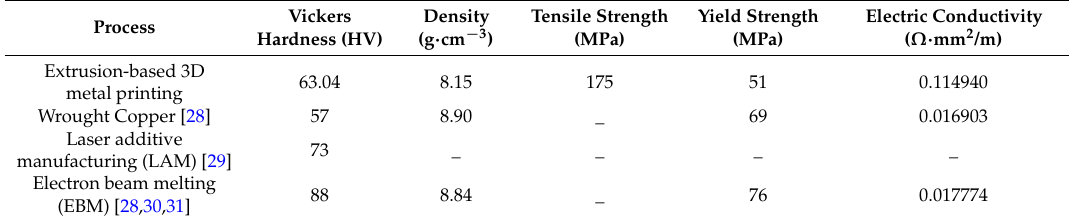
Table 9. Properties of copper samples prepared by different processes.